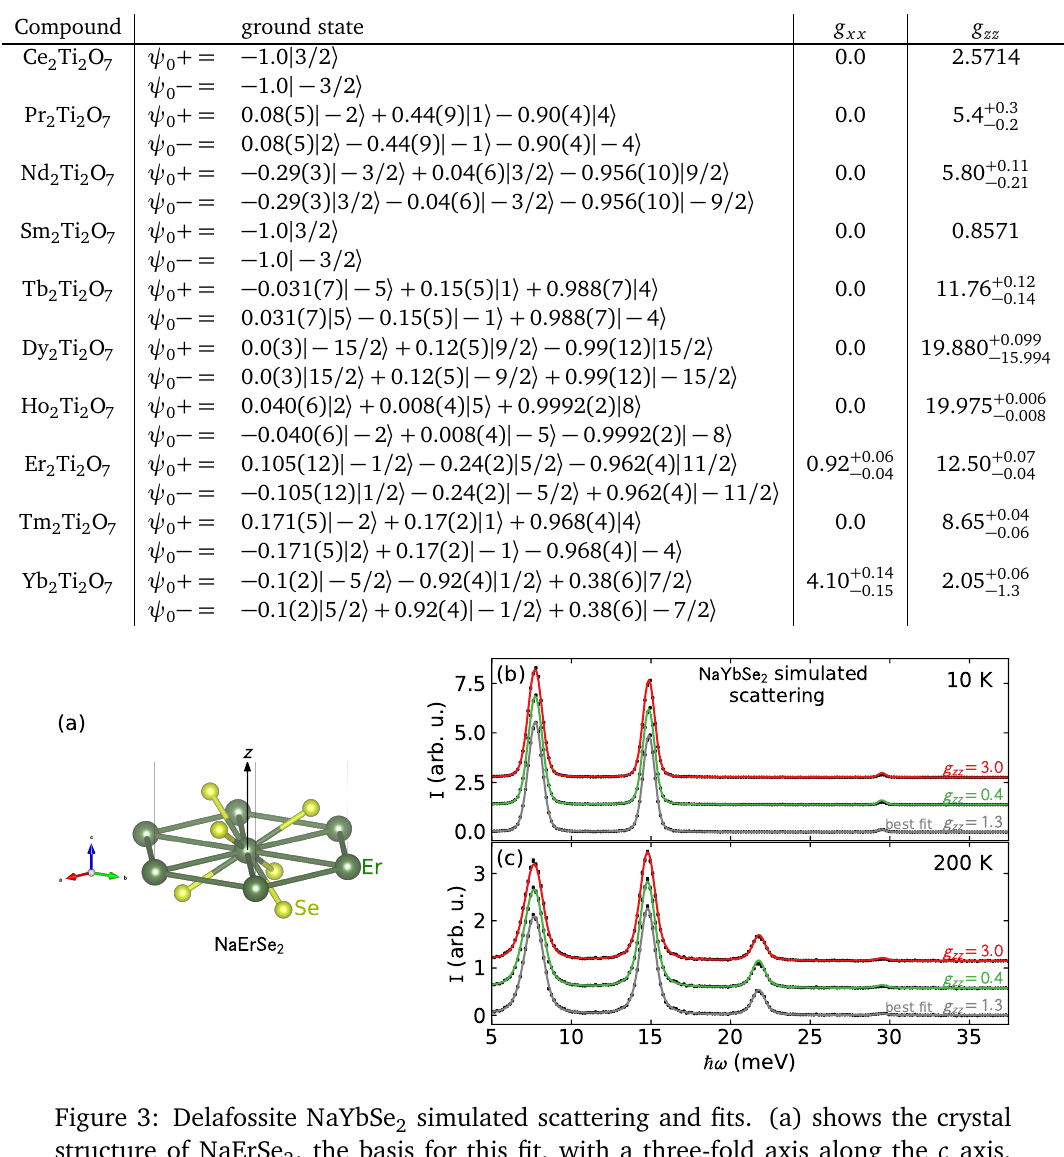
Table 3: Uncertainties in the CEF Hamiltonian of pyrochlore Yb replaced with other rare earth ions. Only the three largest contributions to the ground state eigenket are listed. Sm 3 + and Ce 3 + both have a uniquely defined ground state constrained by symmetry despite variation in CEF parameters, but the rest allow for variation in the ground state wavefunction. Of all the ions, Yb 3 + and Dy 3 + have the largest g tensor uncertainty. Note that many ions listed are non-Kramers and are not in general required to have a doubly-degenerate ground state, but do because of the pyrochlore lattice symmetry.